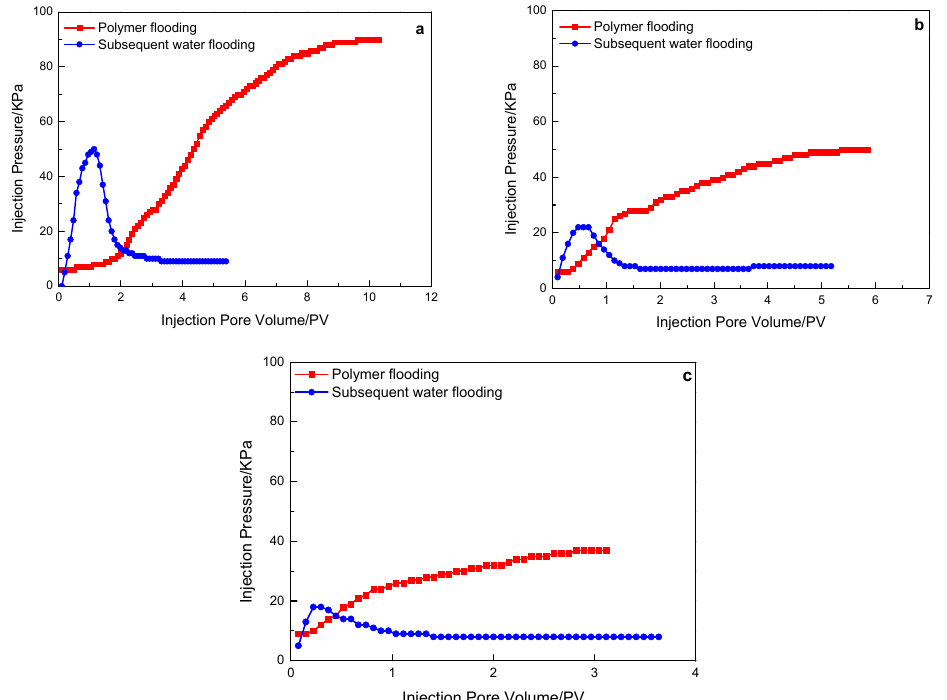
Figure 6. A 16 million molecular weight polymer solution in rock cores with different permeability, the characteristics of the injection pressure of polymer flooding and subsequent water flooding: ( a ) 500 mD core; ( b ) 1000 mD core; ( c ) 2000 mD core.